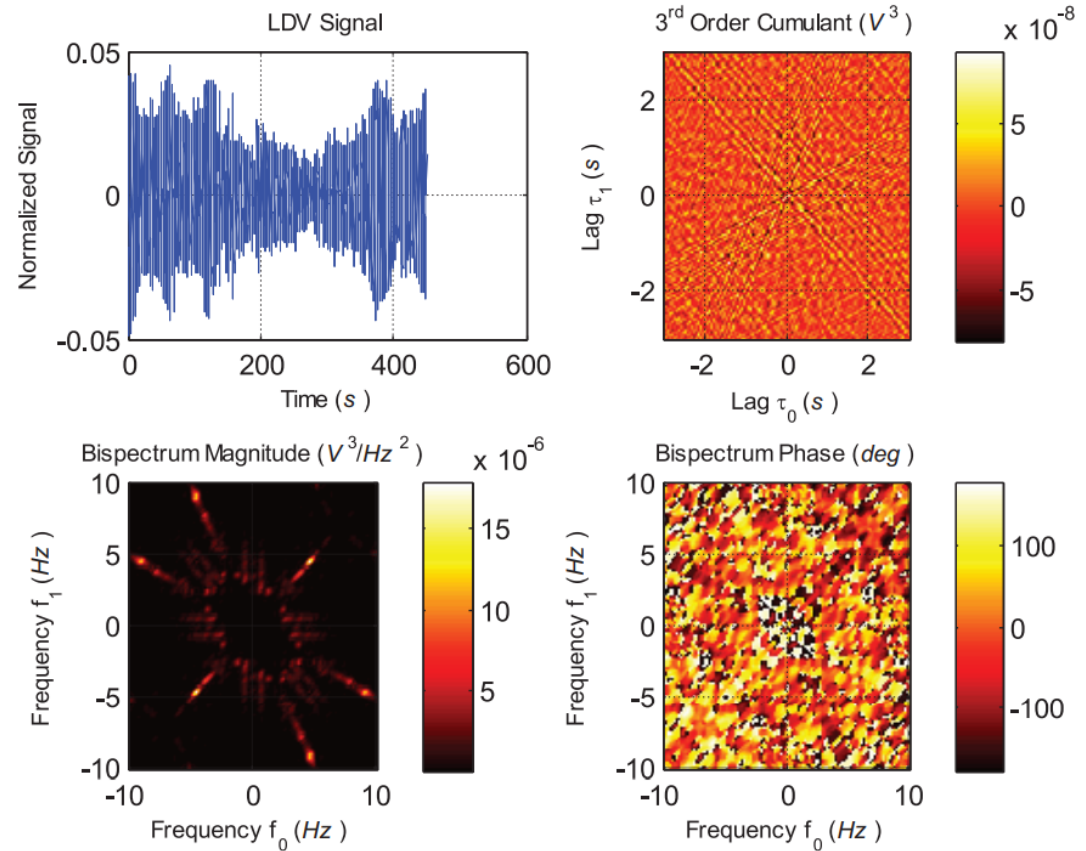
Figure 18. Normalized acceleration signal, its cumulant, and bi-spectrum [50].